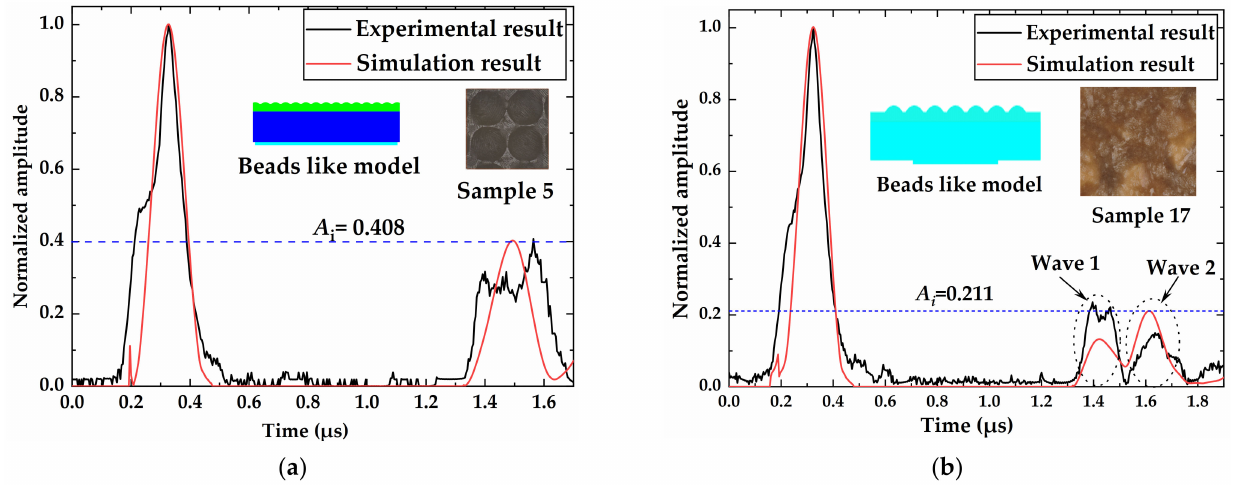
Figure 14. Comparison between experimental and simulated envelopes of echo signals: ( a ) echoes from top of ice with regular bead profile and with Ra = 38.5 µ m and Sa = 39.5 µ m; ( b ) echoes from bead-like profile with Ra = 108 µ m and irregular roughness profile with Sa = 108.8 µ